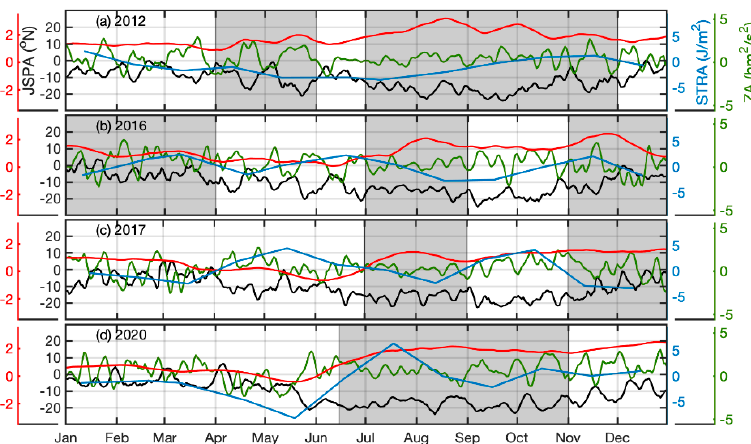
Figure 11. Time series for major Marine Heatwave years 2012 ( a ), 2016 ( b ), 2017 ( c ), and 2020 ( d ). JS position anomaly (JSPA) (°N) (black), average SSTA (°C) (red), and average Z anomaly (ZA) (hm 2 /s 2 ) at 300 hPa(green), and average monthly Surface Thermal Radiation anomaly (STRA) (blue). All av- erages were taken over 40–48°N and 70–48°W. JSPA was calculated from the daily latitude minus the mean latitude of the daily strongest winds at 300 hPa averaged across 70–48°W in the North Atlantic. Time series was smoothed with the moving average.